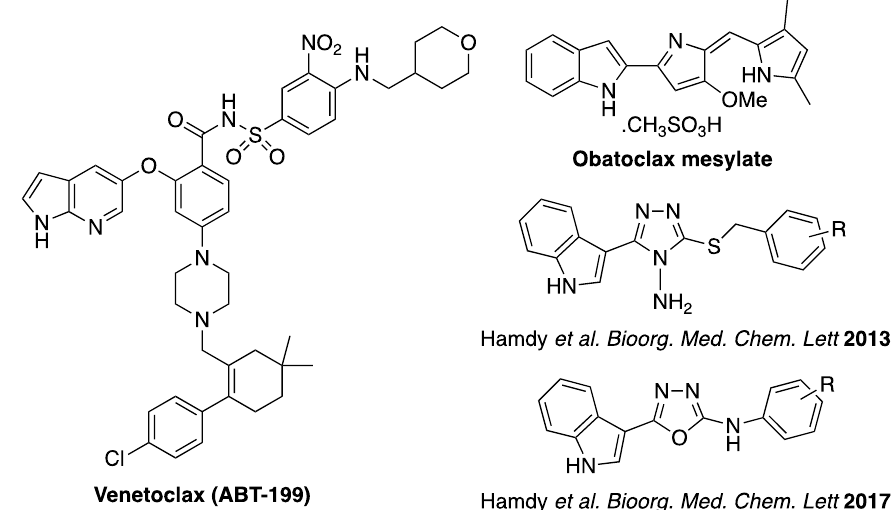
Figure 1. Bcl-2 small molecule inhibitors.